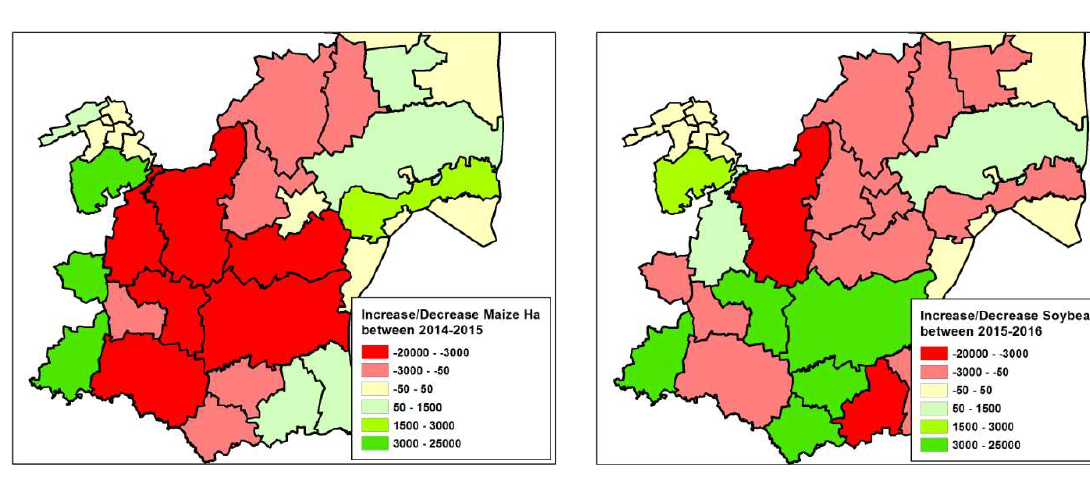
Figure 19. Calculated increase or decrease in area (Ha) of maize cultivated in 2015 and 2016 in